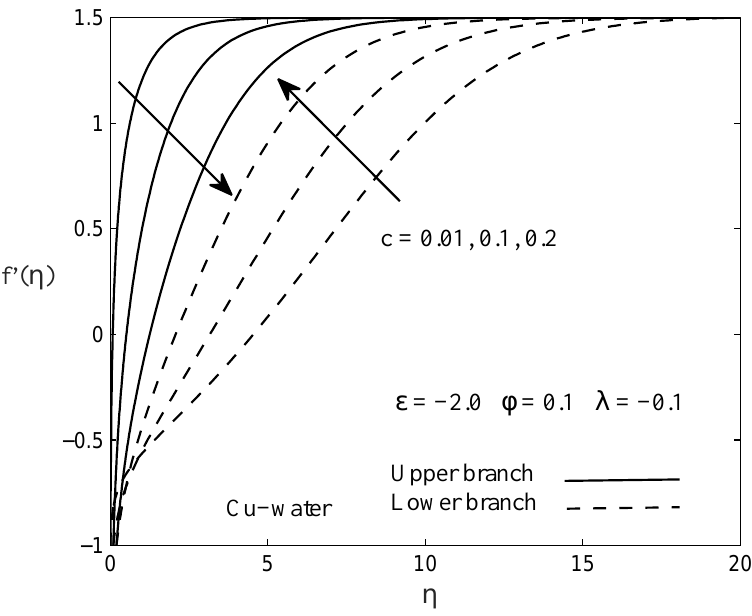
Figure 10. Effect of needle size c on the variation of velocity profiles.